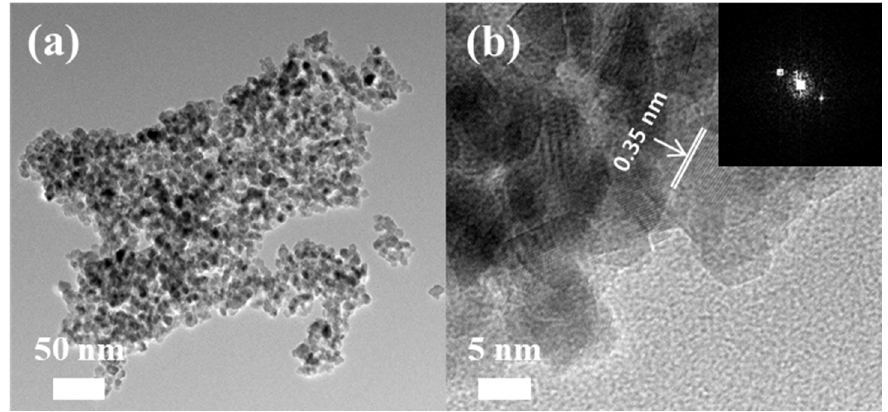
Figure 5. ( a ) Transmission electron microscopy (TEM) image and ( b ) high resolution transmission electron microscopy (HR ‐ TEM) image (inset: selected area electron diffraction (SAED) pattern) of the TiO 2 film templated by POEM.